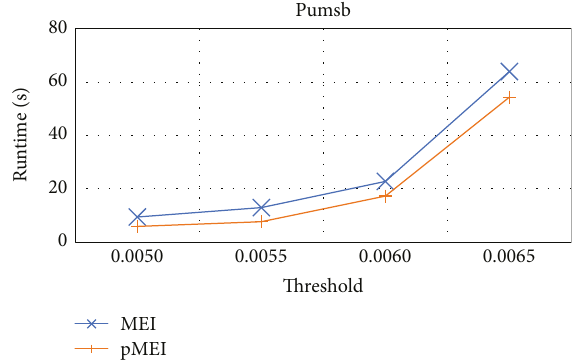
Figure 3: Runtimes of the MEI and pMEI methods on the Chess.